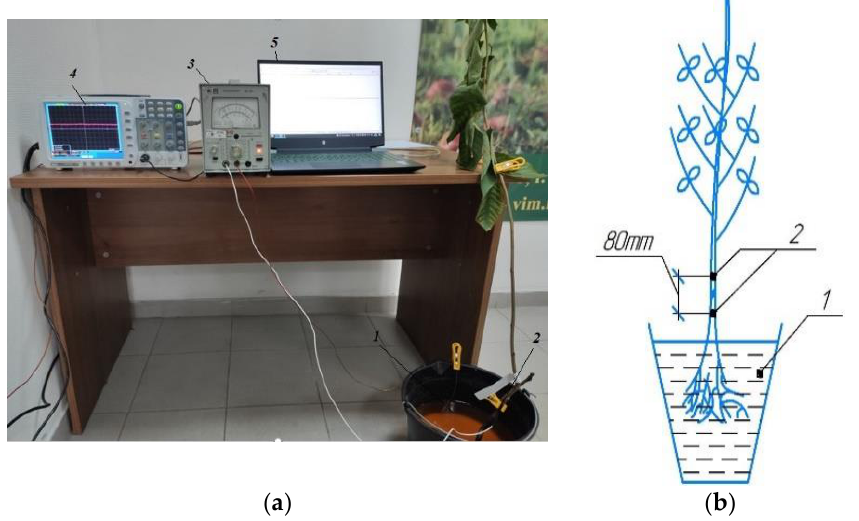
Figure 4. The process of measuring the electrical resistivity of the grafting zone in a sweet cherry seedling 6 months after treatment: ( а ) photograph; ( b ) scheme. The seedling is immersed in the solution and the measuring electrodes are made of silver. 1 — electrode immersed in the solution; 2 — electrode inserted into the cambial layer of the bark of the seedling; 3 — teraohmmeter; 4 — oscilloscope for recording teraohmmeter readings; 5 — PC connected to the oscilloscope. The electrodes are inserted alternately below the grafting area and above. According to the difference in resistance, the resistance of the grafting zone is determined.